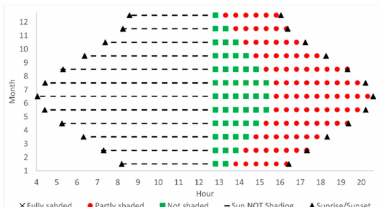
Figure 13. State of shading: east-facing surface, latitude 52.21 ◦ N, D = 20 m, H = 10 m, L = 40